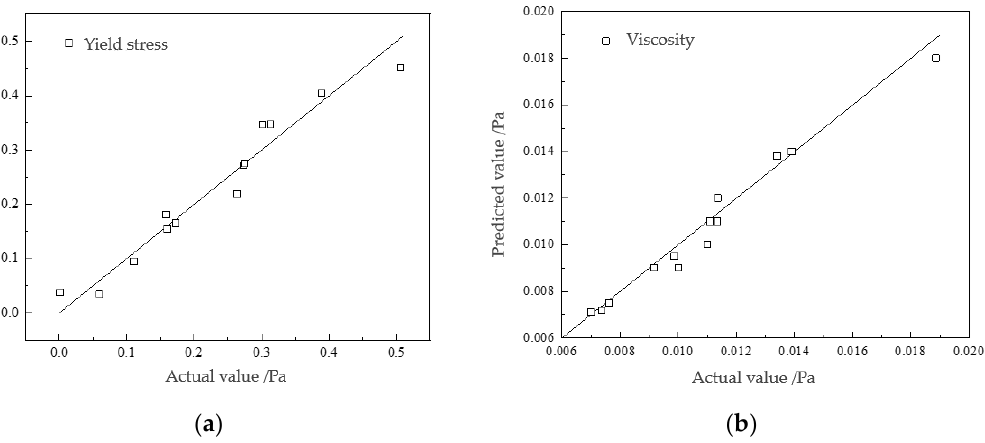
Figure 6. Comparison of actual value and predicted values of yield stress and viscosity. ( a ) Com- parison of actual value and predicted values of yield stress; and ( b ) comparison of actual value and predicted values of viscosity.